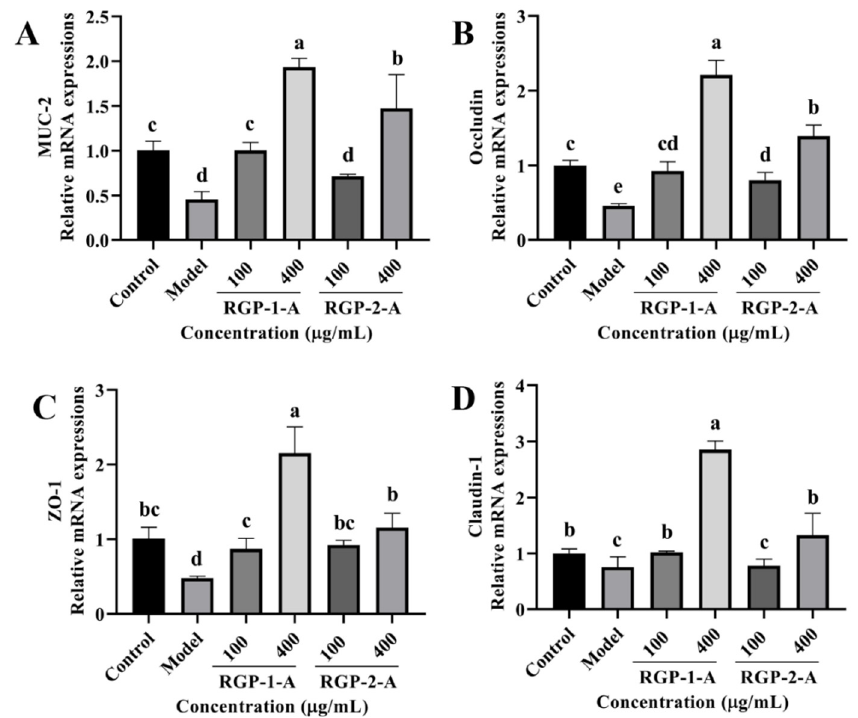
Figure 11. Effect of RGP on the relative mRNA expression of barrier-related proteins. ( A ): MUC-2, ( B ): occludin, ( C ): ZO-1, ( D ): claudin-1. RGP-1-A: decolorized pure polysaccharides of RGP obtained using AB-8 macroporous resin; RGP-2-A: decolorized pure polysaccharides of RGP obtained using H 2 O 2 . On the bar graphs, different lowercase letters signify a significant difference ( p <